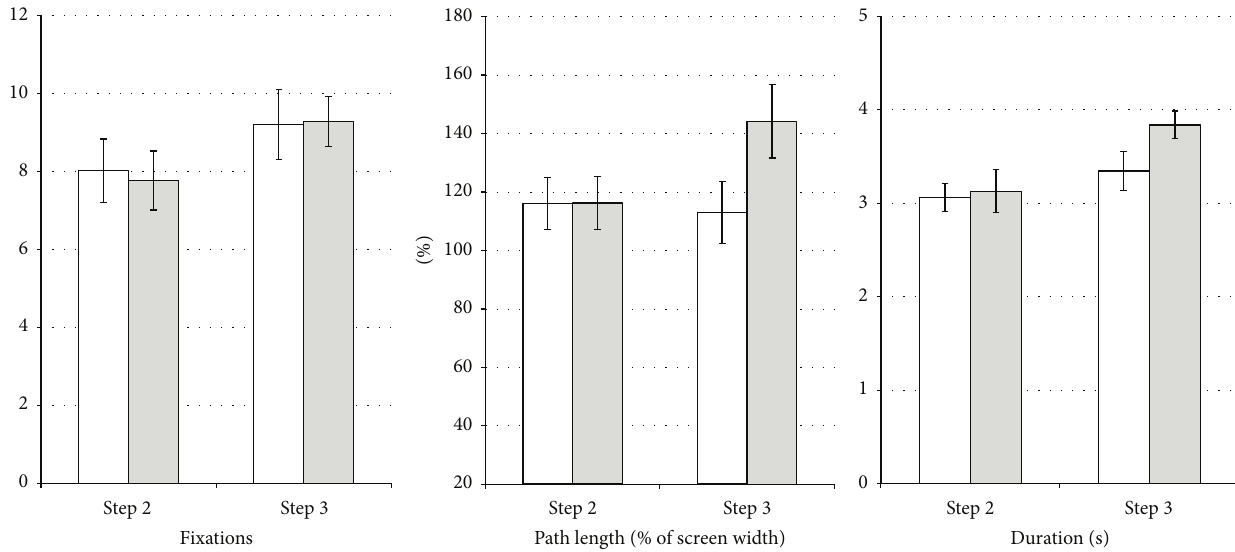
Figure 3: In experiment 2 , on the second task step the interfaces are indistinguishable, but on the third step the translated interface (grey bars) requires a longer path length and takes longer to complete than the collocated interface (white bars). Error bars indicate standard error.